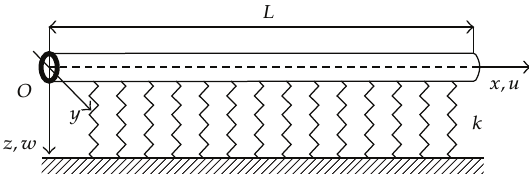
Figure 1: Model of an embedded carbon